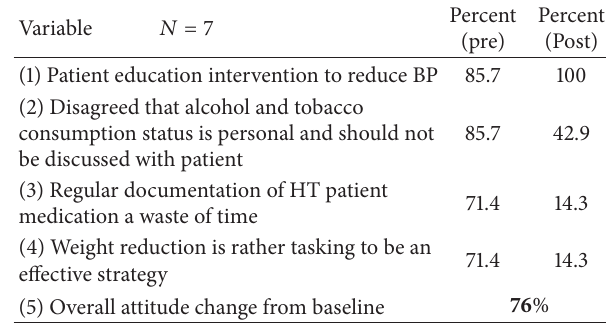
Table 3: Proportion of participants’ correct responses on accurate BP measuring skills with the help of a Standardized Blood Pressure Measurement Techniques Skills Checklist.